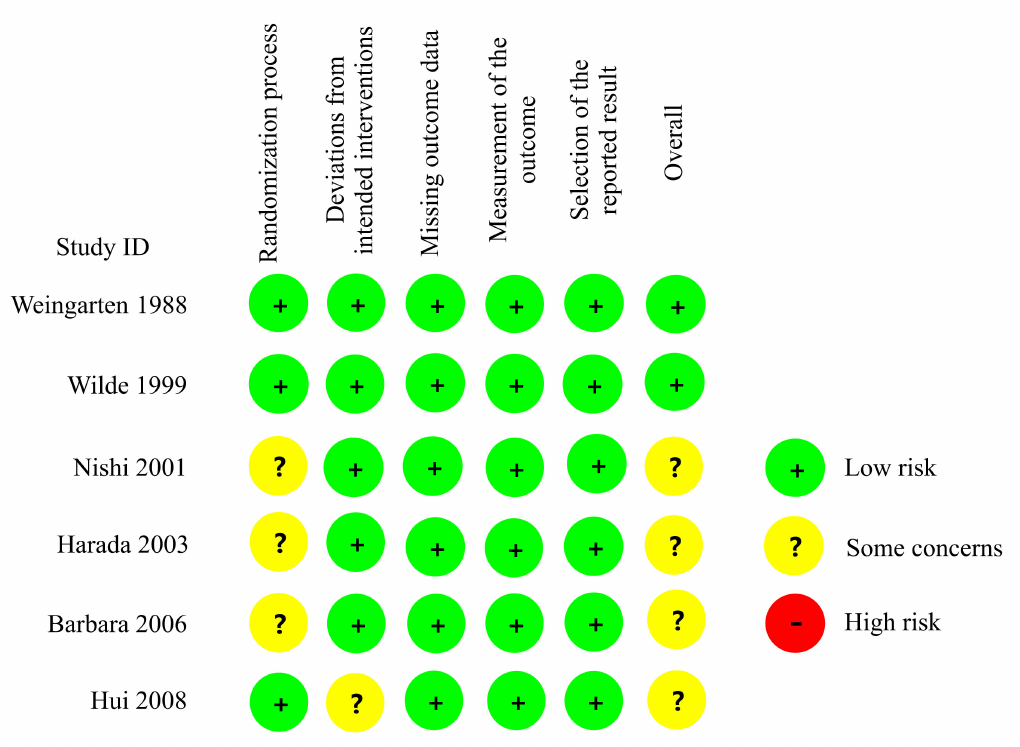
Figure 2. Quality assessment of the six randomized controlled trials. ID,